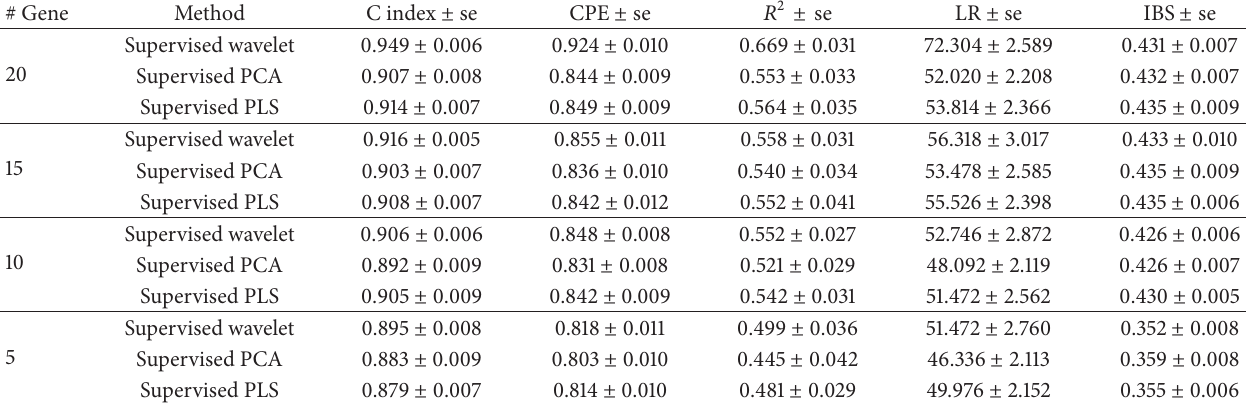
Table 4: Performance of different Cox models for lung cancer dataset (clinical + genomic